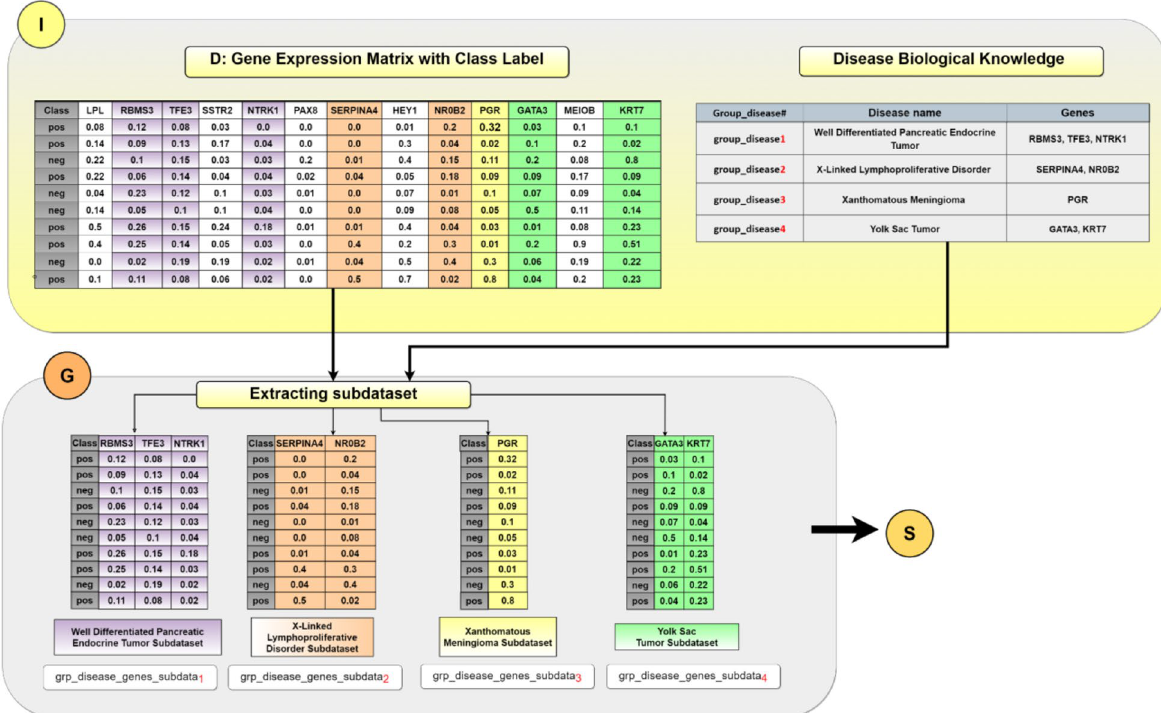
Figure 4. An example of creating two-class subdatasets extracted according to disease-group names. These subdatasets will be subject to the S component for